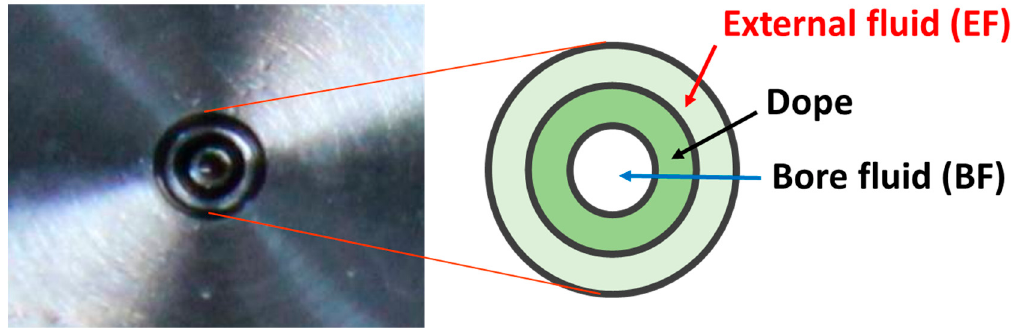
Figure 1. Scheme of the triple-orifice spinneret used for preparing the hollow fibers (HFs).